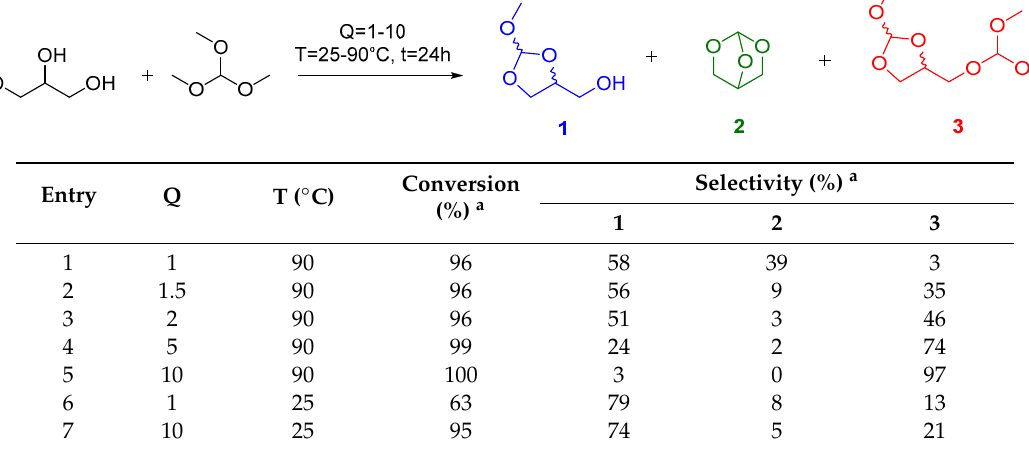
Table 1. Q and T effect on products distribution for the catalyst-free reaction of Gly with Table 1. Q and T e ff ect on products distribution for the catalyst-free reaction of Gly with HC(OMe).